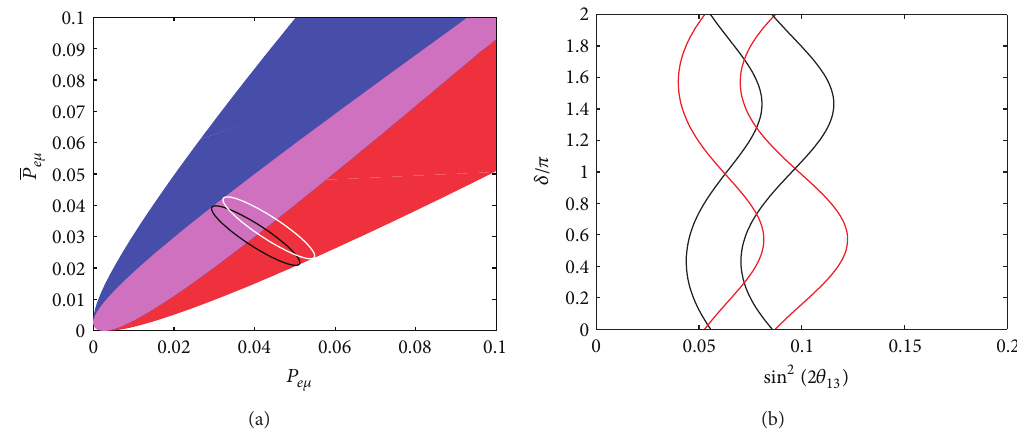
Figure 12: Two different illustrations of parameter space degeneracies. Left panel: biprobability plot for 𝐿 = 295 km and 𝐸 = 0.65 GeV. The red band indicates the possible values of the probabilities for normal hierarchy, the blue for inverted, and the pink for the intersection of the two. The black and white ellipses represent the possible values of the probabilities for two different fixed values of 𝜃 13 . Right panel: probability isocontours of 𝑃 𝜇𝑒 (black) and 𝑃 𝜇𝑒 (red). The values of the probabilities correspond to those of the intersections between the black and white ellipses in the left panel (with the thick lines representing the upper left intersection). The intersections are where the parameter values reproduce the oscillation probabilities for both neutrinos and antineutrinos.